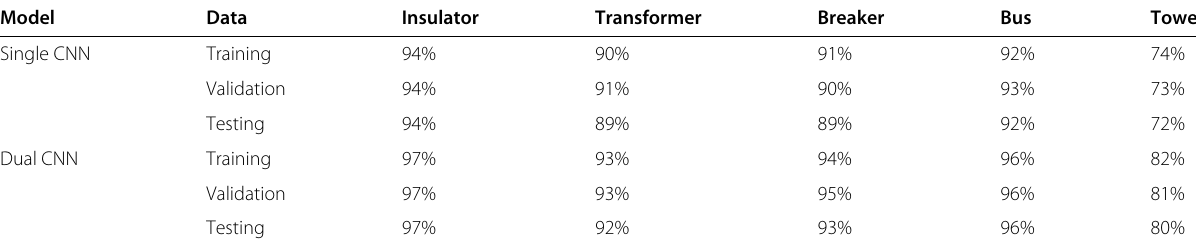
Table 1 The comprison of accuracy rate for two models Model